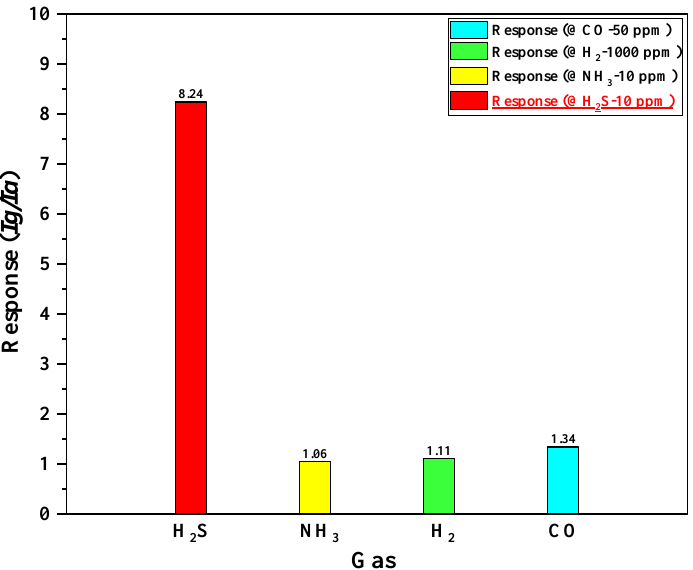
Figure 10. Measured responses of the SnO 2 -based H 2 S microsensor with micro-heater of type #3 to different tested gases.